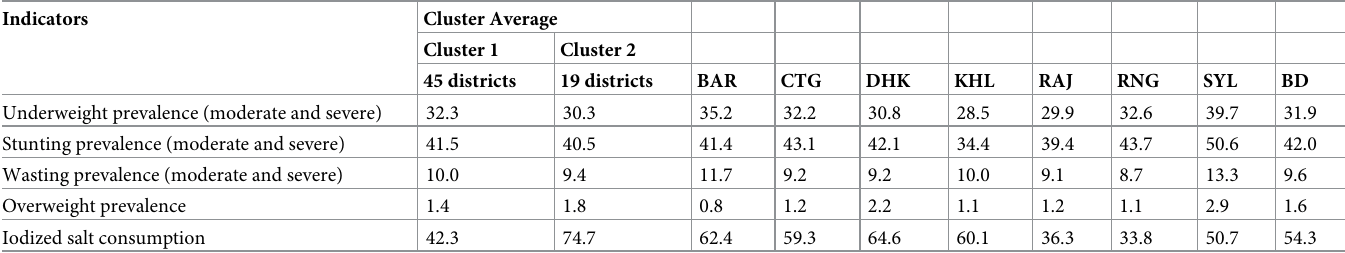
Table 3. Cluster averages of districts along with averages of the divisions and Bangladesh as a whole based on nutrition indicators. Indicators